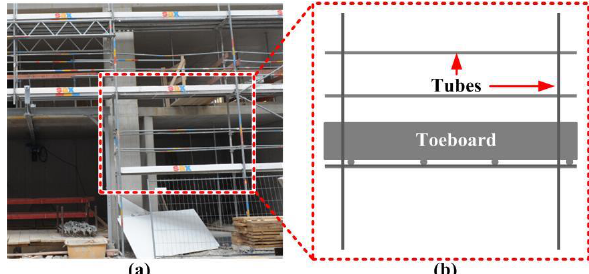
Figure 1. a) Real photo of scaffolds, b) toeboards and tubes in the scaffolds.